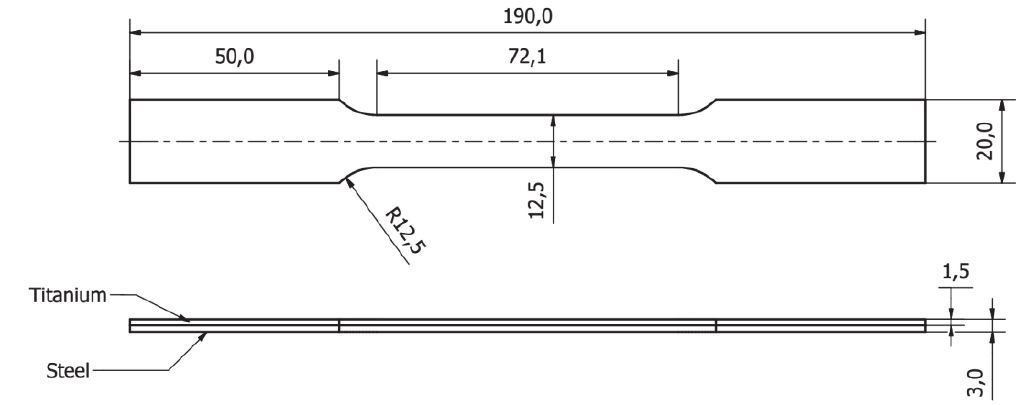
Figure 3: Shape and dimensions of the interface zone